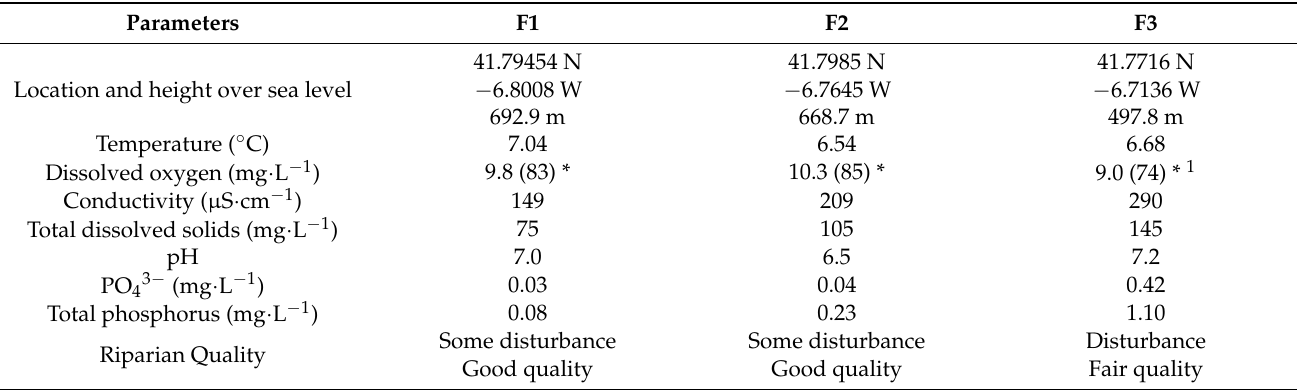
Table 1. Location, channel and riparian indexes, macroinvertebrate community structure and some water parameters (mean values) in F1, F2, and F3 at the time of the present